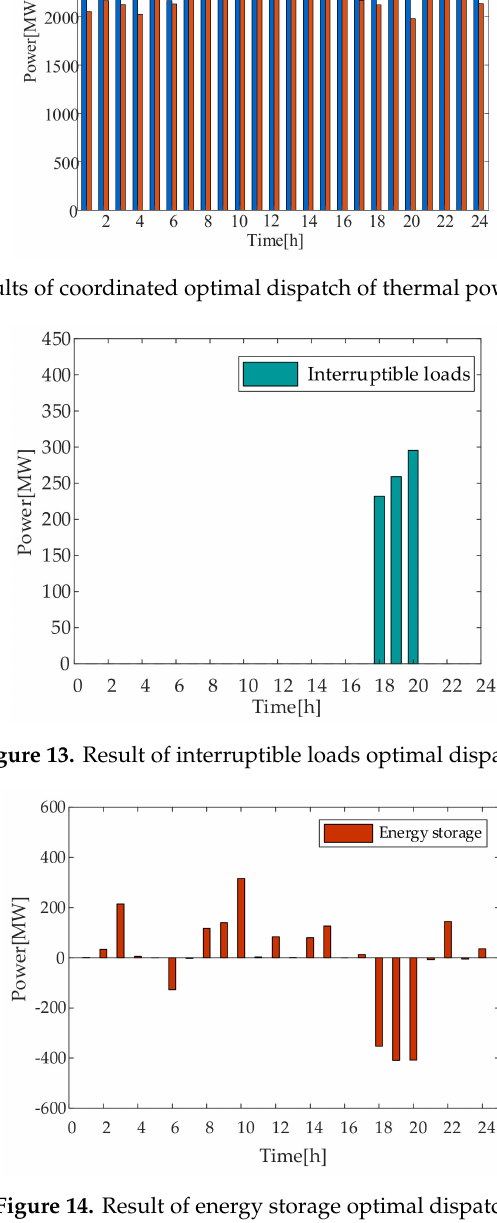
Figure 14. Result of energy storage optimal